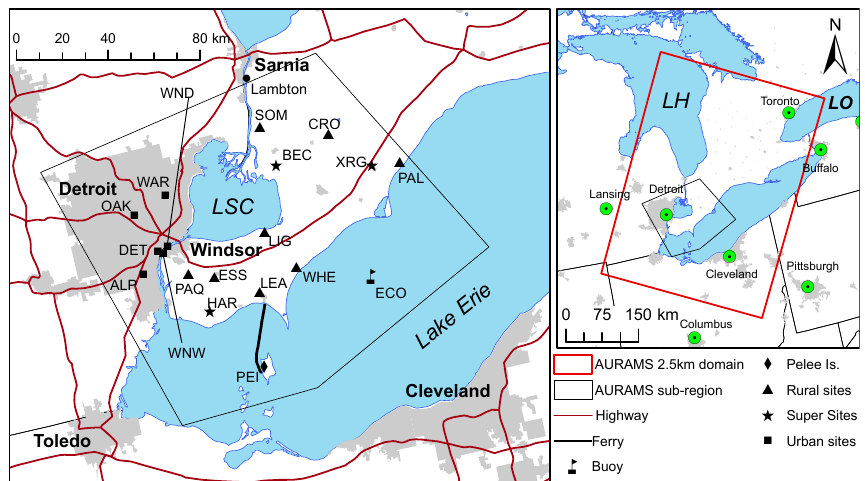
Fig. 1. Map of study region, indicating (left) model analysis sub-domain and the locations of chemistry supersites (BEC – Bear Creek, XRG – Ridgetown, HAR – Harrow), monitoring stations, buoy (ECO), ferry route, and main urban areas (gray shaded regions), and (right)